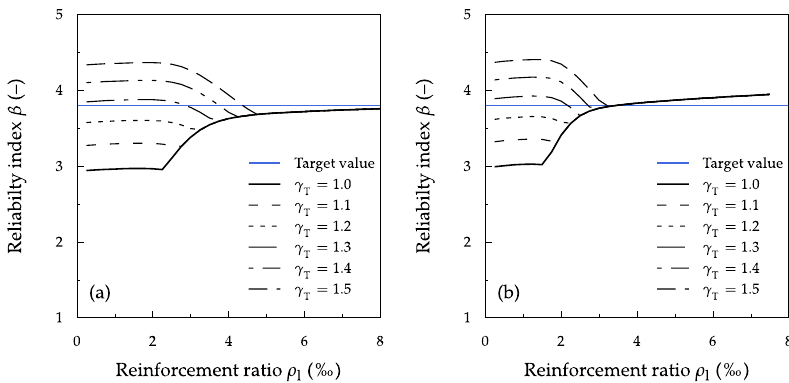
Figure 10. Reliability indices calculated according to FORM considering an effective depth of d = 60 mm: ( a ) AR-glass textiles; ( b ) carbon textiles.